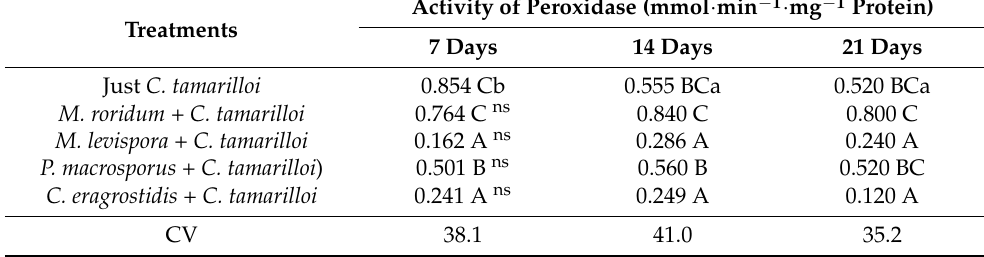
Table 6. Activity of the enzyme peroxidase in rubber tree seedlings after preventive treatments with saprobic